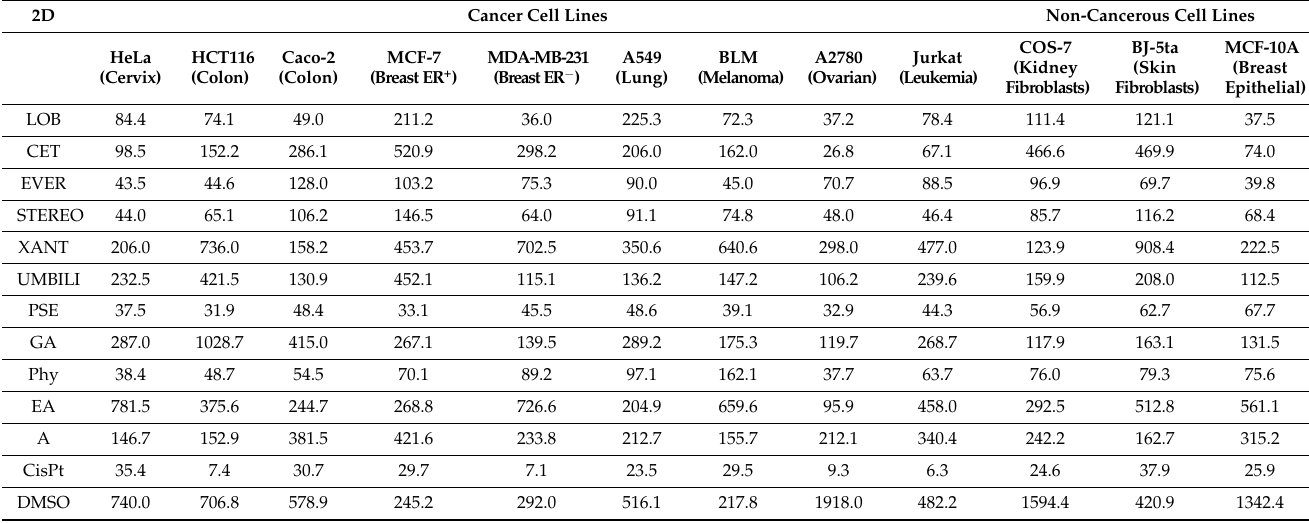
Table 2. IC 50 values ( µ g/mL or µ M) list from 2D screening analyses.